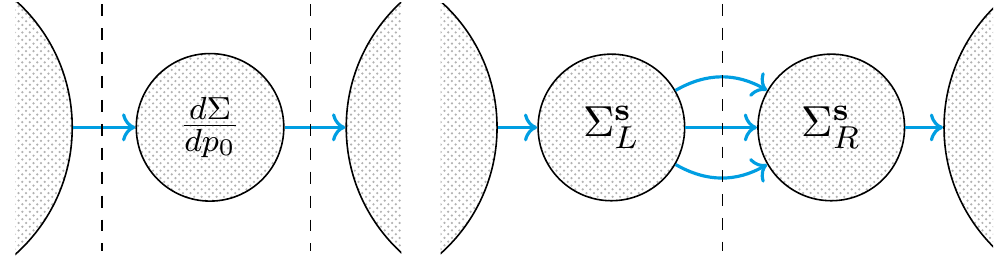
Figure 11. On the left, the derivative of the two point function with cuts on both of the propagators adjacent to it, obtained from the modified Cutkosky rule (4.4). It has the same IR structure as the sum of contributions which can be written as the diagram on the